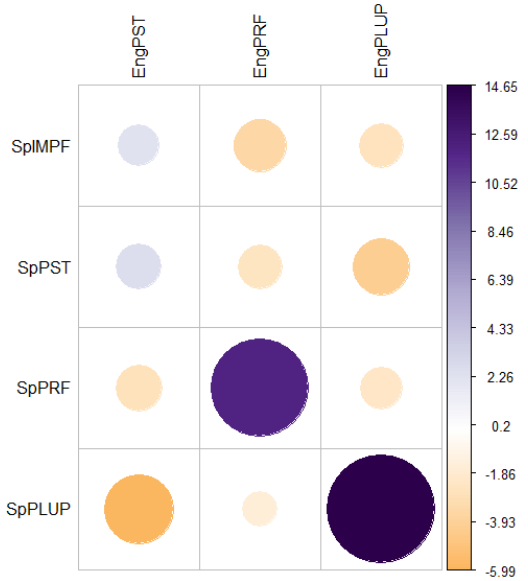
Figure 5. Visualization of Pearson residuals of Spanish tenses translated to English tenses in dialogue.